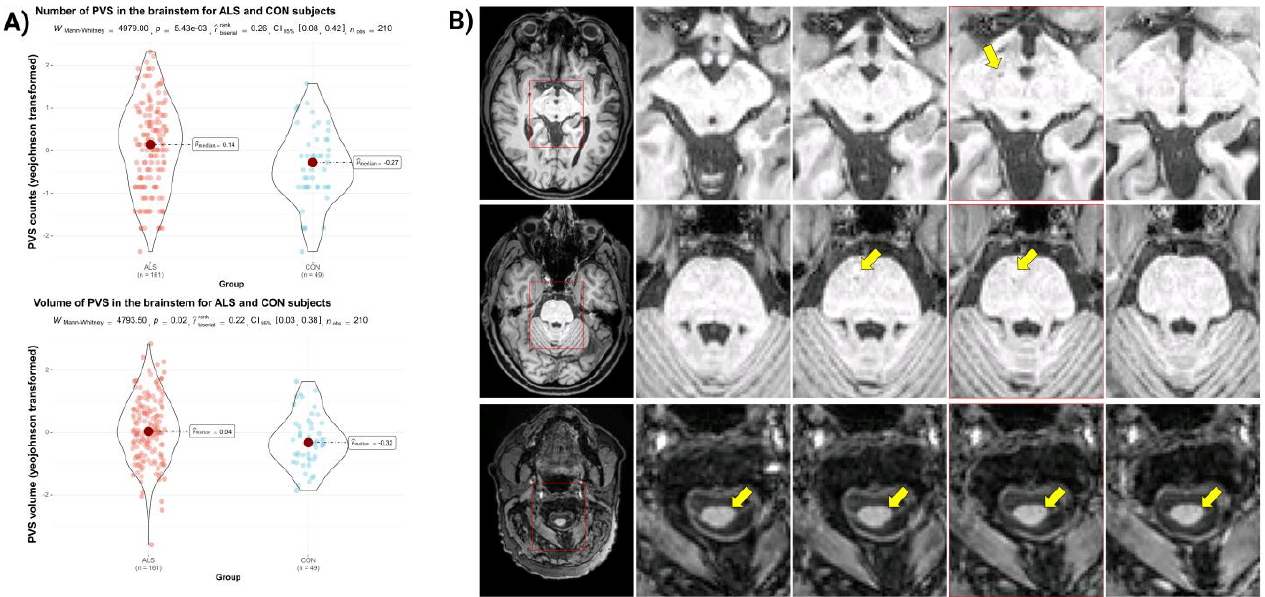
Figure 3. The total burden (count and volume) of PVS in the brainstem is significantly higher in subjects with ALS than in controls. We quantified PVS in a case-control study ( n = 210; 76 female; median age 71.67 [IQR 62.80, 79.77] years; ALS/CON 161/49; T1w and FLAIR). In summary, the considered pipeline uses FreeSurfer [115] and FAST [116] for segmenting healthy and pathological white matter regions (T1w for whole brain parcellation and FLAIR for white matter hyperintensity segmentation), the Frangi filter for enhancing tubular structures (e.g., PVS), hard thresholding for segmenting PVS and connected component analysis for determining counts and volumes [117]. We transformed measurements using the Yeo–Johnson transform to deal with skewness. ( A ) In univariate analysis, we found that the count and volume of PVS in the brainstem were significantly higher in subjects with ALS than in CON (counts: Wilcoxon–Mann–Whitney = 4979, p = 5.43 × 10 − 3 ; volumes: Wilcoxon–Mann–Whitney = 4793, p = 0.02). The pattern remained even after controlling for age and sex (counts: 0.07 [95%-CI − 0.07, 0.21] for ALS vs. − 0.37 [95%-CI − 0.62, − 0.12] for CON, p = 0.003; volumes: 0.05 [95%-CI − 0.09, 0.19] for ALS vs. − 0.28 [95%-CI − 0.54, − 0.03] for CON, p = 0.025). ( B ) In subjects with ALS, PVS (yellow arrows) may appear enlarged in the brainstem. The original T1w image and the area we zoomed in on (red square) are both displayed in the first column. The fourth column shows the reference slice. The second and third columns are slices inferior to the reference whereas the fifth one is a slice superior to it. ALS, amyotrophic lateral sclerosis; CON, controls; FLAIR, Fluid-Attenuated Inversion Recovery; PVS, perivascular